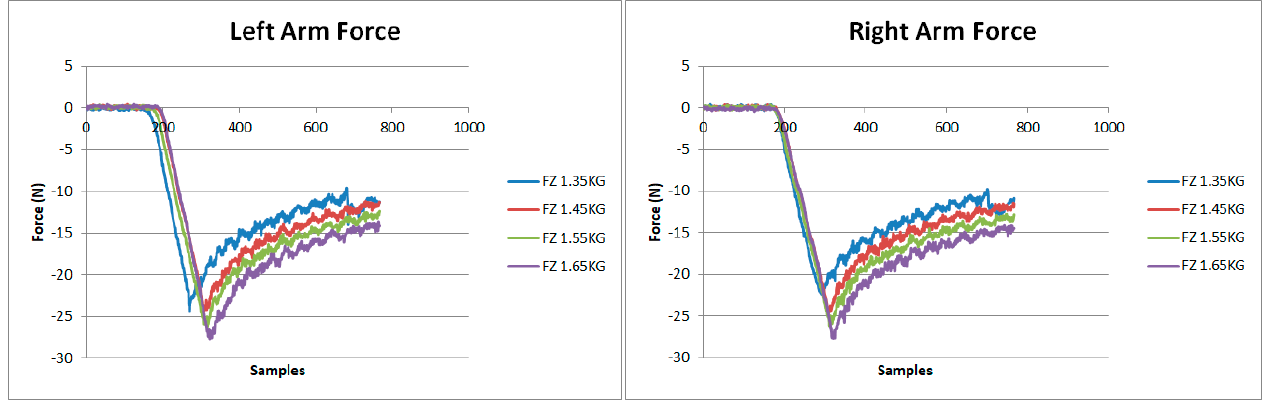
Figure 11. Validation of the friction coefficient (mu = 0.3) previously set up for lifting boxes.